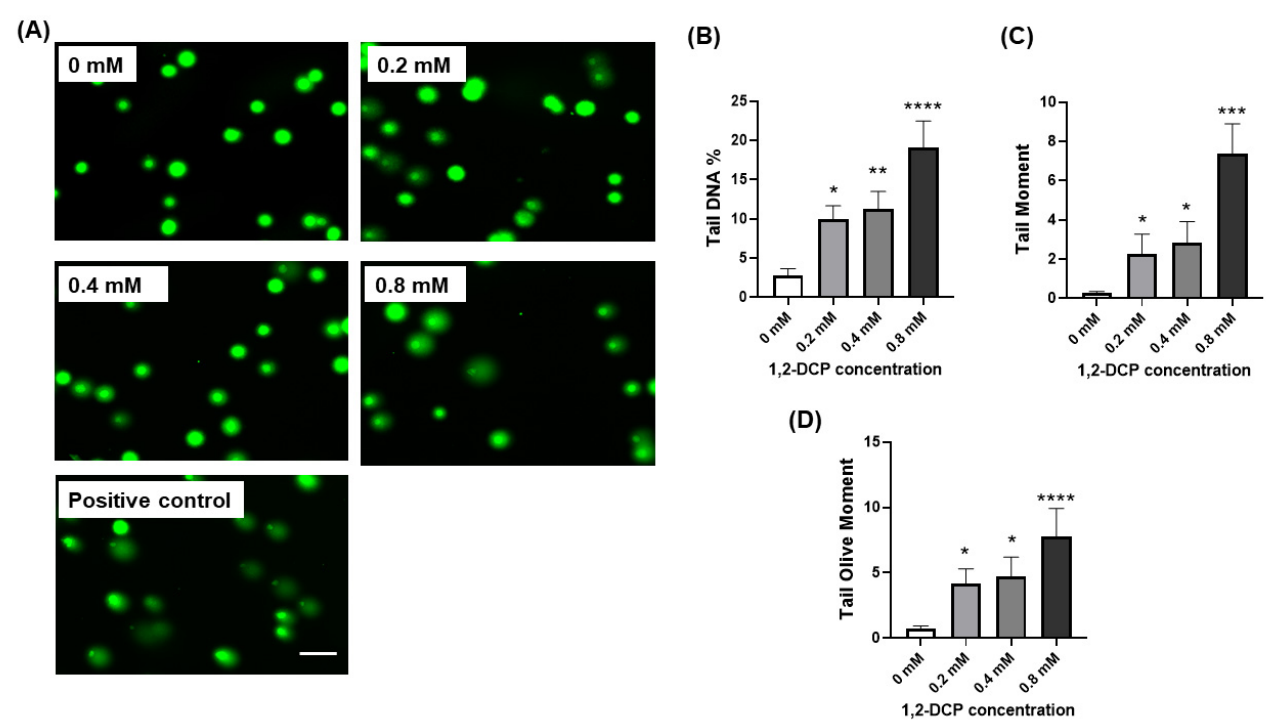
Figure 6. Effects of 1,2-DCP on DNA in MMNK-1 cholangiocytes/THP-1 macrophages, as assessed by Comet assay. Co-cultures of MMNK-1 cholangiocytes and THP-1 macrophages were exposed to 1,2-DCP at 0, 0.2, 0.4, and 0.8 mM for 24 h. For positive control, MMNK-1 cholangiocytes were exposed to 0.2 mM of H 2 O 2 for 2 h. Alkaline Comet assay was performed. Scale bar: 100 µm. ( A ) Photomicrographs of Comet assay staining. ( B ) Tail DNA%. ( C ) Tail moment. ( D ) Tail olive moment. Data are mean ± SD, n = 3. * p < 0.05, ** p < 0.01, *** p < 0.001, **** p < 0.0001, compared with the control group (0 mM), by one-way ANOVA followed by Dunnett’s multiple comparison test.